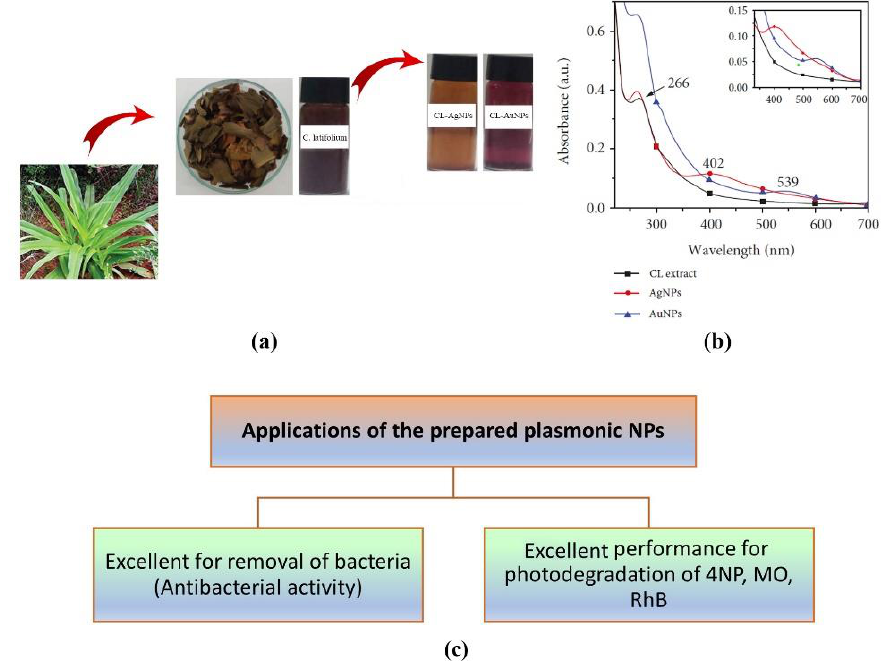
Figure 2. Biosynthesis of CL–AgNPs and CL–AuNPs explained by Vo et al.: ( a ) preparing the extract of oven-dried leaves of CL and modifying it with Ag and Au NPs; ( b ) comparing the light absorbance of different compositions of the modified CL-based NPs; and ( c ) applications of the prepared Plasmonic NPs in wastewater treatment. Reproduced with permission from [94]. Copyright © 2019, Hindawi.